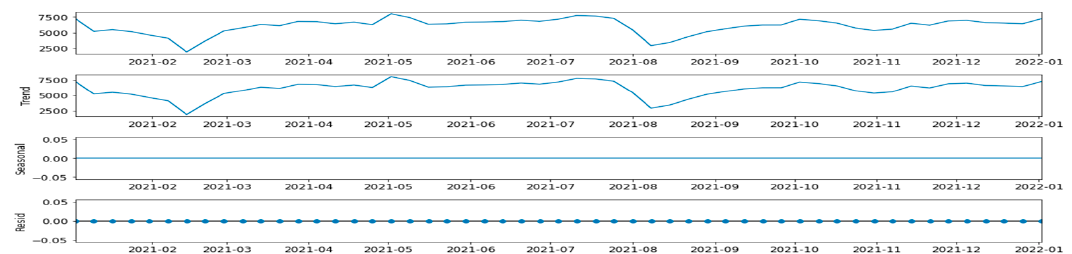
Figure 6. The daily series decomposed plot.